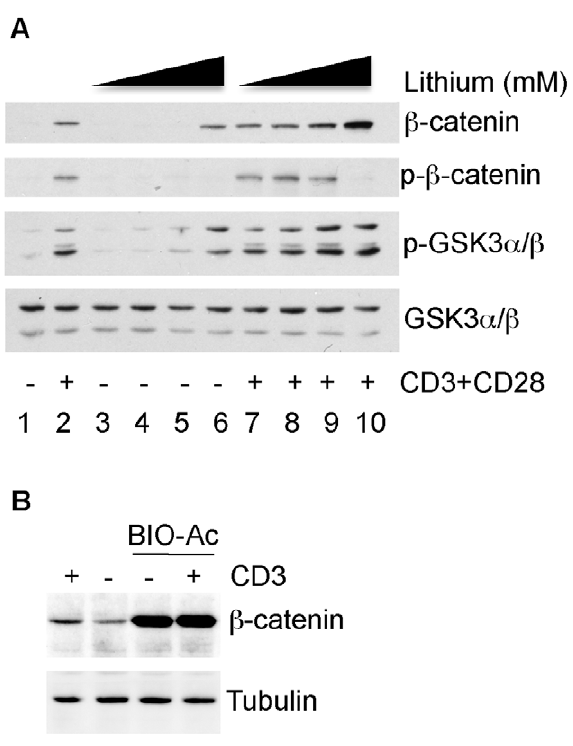
Figure 2. GSK3 regulates the expression of b -catenin down- stream of TCR signalling. (A) Primary human T cells were left unstimulated (lane 1) or stimulated for 18 hours with plate bound anti- CD3 and anti-CD28 antibodies (lane 2), or with increasing concentra- tions of LiCl (0, 0.2, 2 or 20 mM, indicated by black triangles, lanes 3–6), or with anti-CD3/CD28 and increasing LiCl concentrations together (lanes 7–10). Total cell lysates were immunoblotted with antibodies specific for b -catenin, phospho- b -catenin (Ser33/37/Thr41, herein referred to as p- b -catenin), phospho-GSK3 a / b (Ser21/9, herein referred to as p-GSK3 a / b ) and GSK3. (B) T cells were stimulated for 18 hours with plate-bound anti-CD3 as indicated, either in the absence or presence of the GSK3 inhibitor Bio-ac at 1 m M. Total cell lysates were analysed by Western blot with anti- b -catenin. An anti-tubulin blot is shown as a control for protein loading. This experiment was repeated twice with similar results.